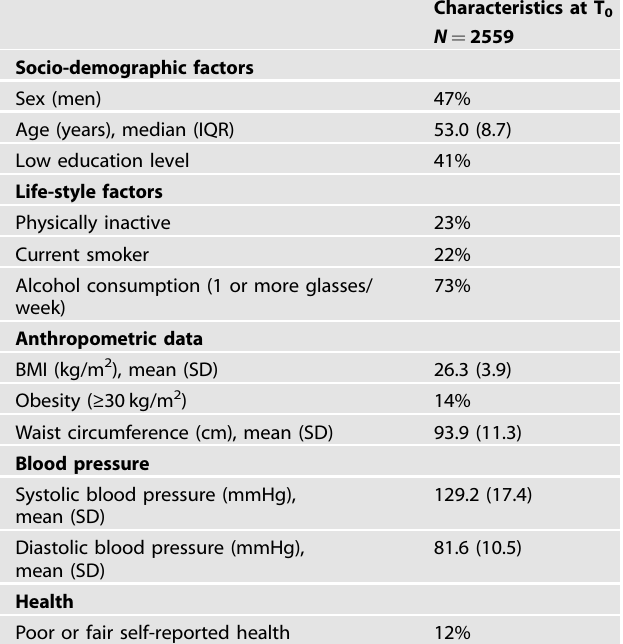
Table 1. Population characteristics at baseline (T 0 ).